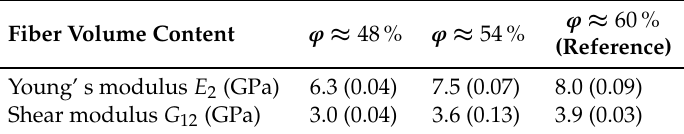
Figure 10. Gapping samples—resulting material stiffness in transverse direction ( a ) and shear modulus ( b ) from off-axis tensions tests (OAT45°). Table 10. Gapping samples—summary of material stiffness results for samples with imposed gaps: from maximal gap width ( ϕ ≈ 48%) to initial state ( ϕ ≈